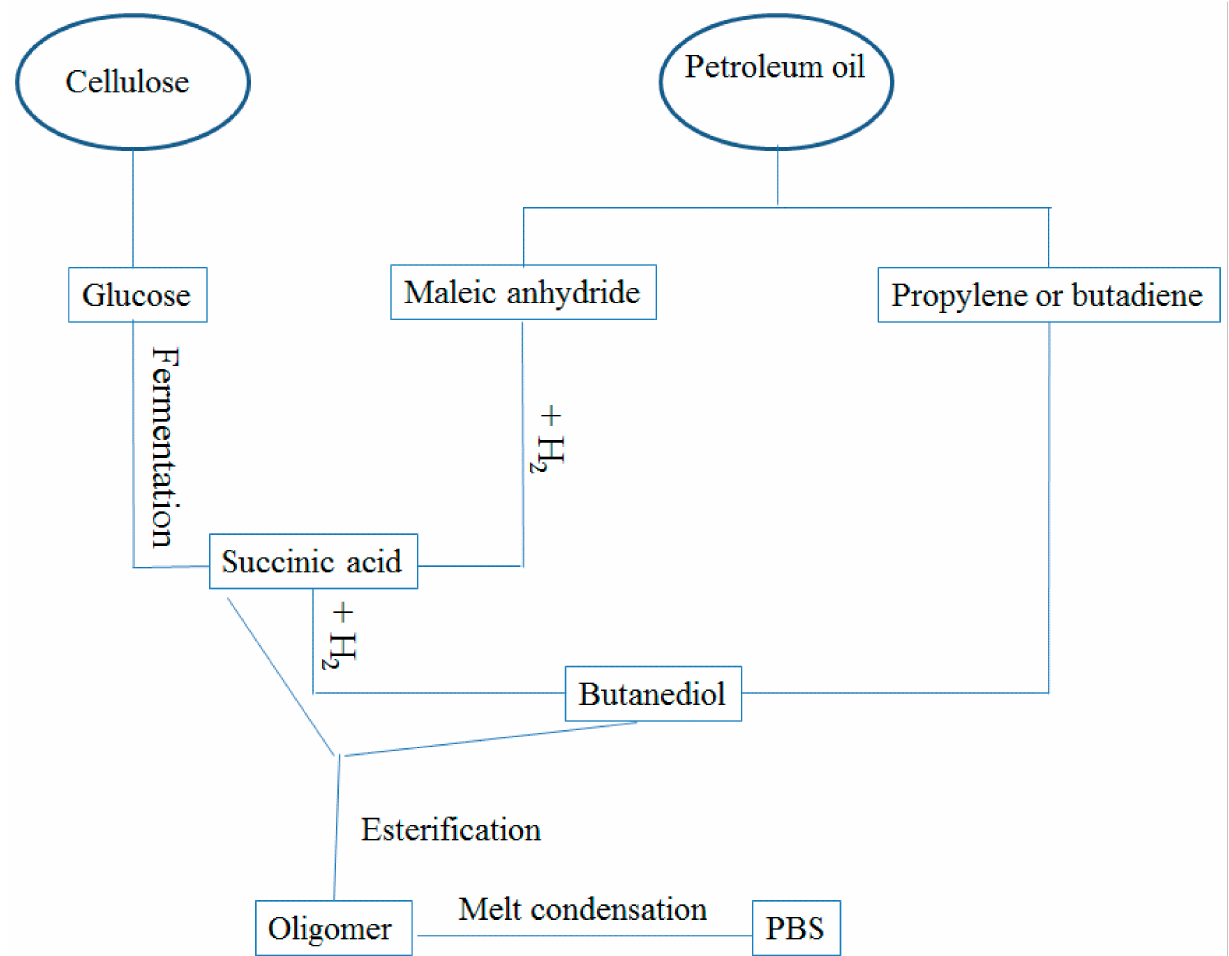
Figure 2. Flow chart representing the production of PBS.